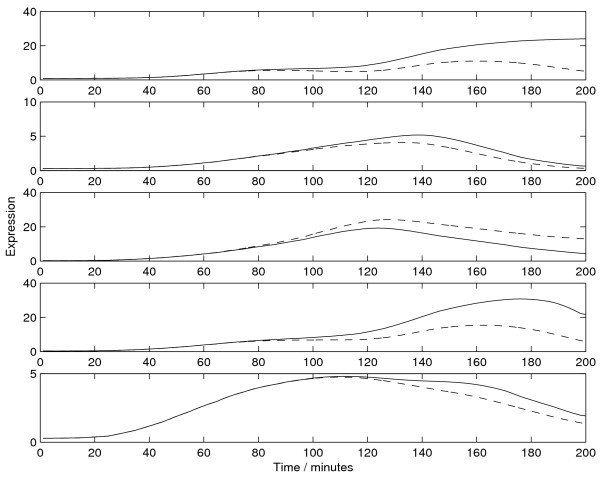
Simulated ground truth signals. Gene expression profiles of the selected genes. The effect of the gene knockout to the expression profiles is clearly observable. Reference signal is shown with solid and test signal with dashed line.